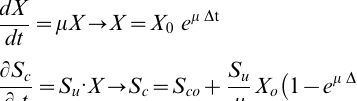
Table S2 Genes with a significative variation on gene